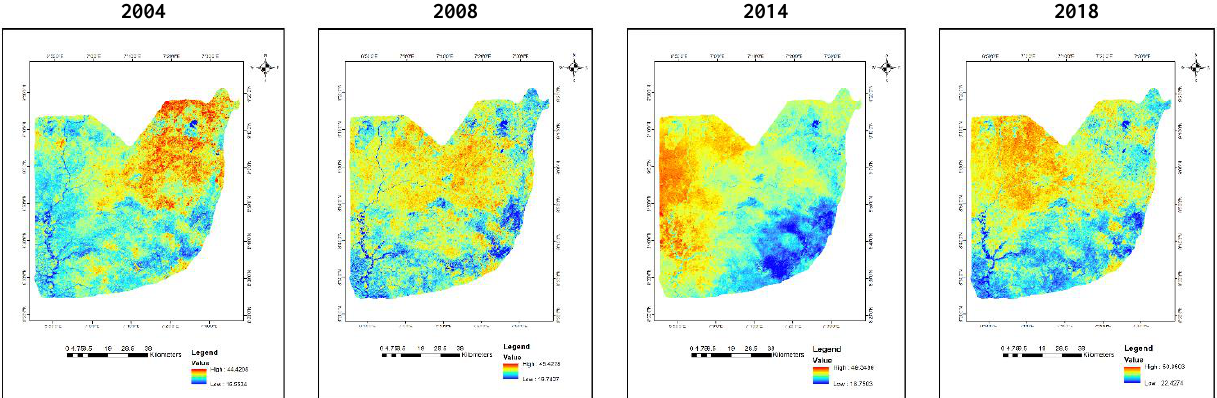
Figure 2. Spatial distribution of the LST in the year 2004, 2008, 2014 and